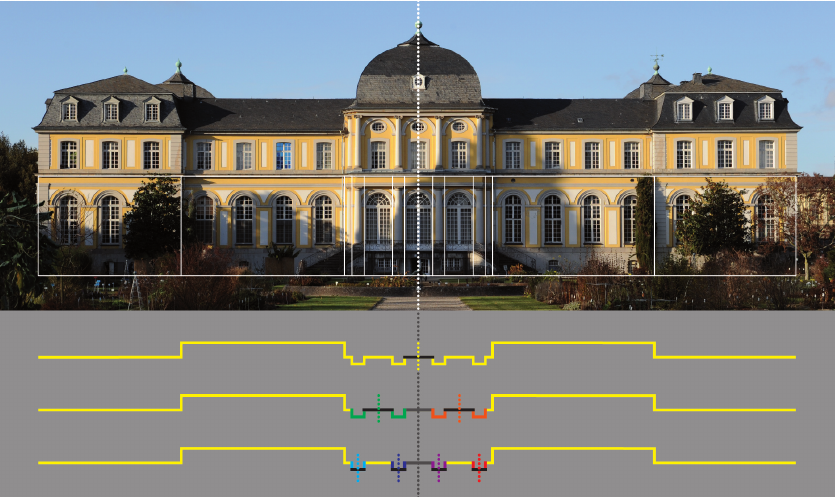
Figure 3: Derived prior knowledge: Global and local axis symmetries of the Poppelsdorf Castle, Bonn, identified from the footprint. The symmetric substructures are highlighted with the same color as the underlying symmetry axis (vertical dotted lines) tiation of the variables, i.e. an assignment of values for each vari- able ( x 1 , a 1 ) , ..., ( x n , a n ) with ( a 1 , ..., a n ) ∈ D 1 × ... × D n so that all constraints are satisfied. Constraints (logic) programming